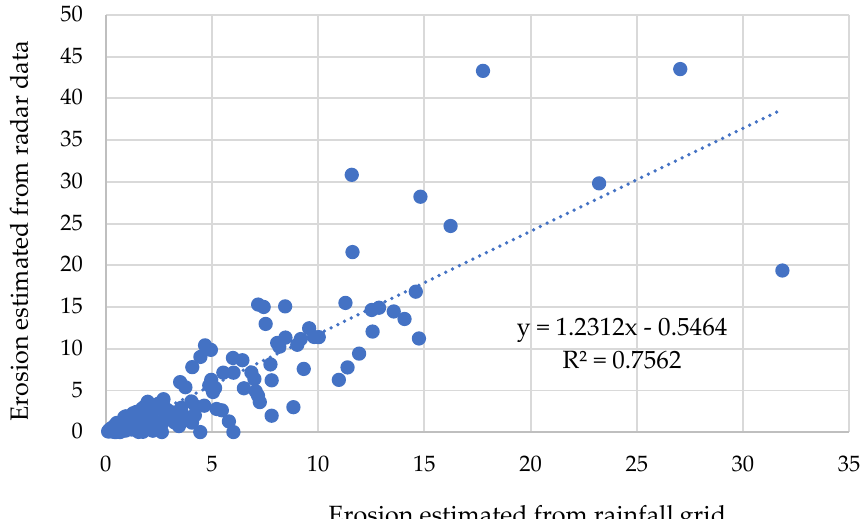
Erosion estimated from rainfall grid Figure 9. Estimated erosion rates (Mg ha -1 month -1 ) from BoM daily rainfall gridded data and radar Rainfields data for January–February 2020 over Sydney drinking water catchment.